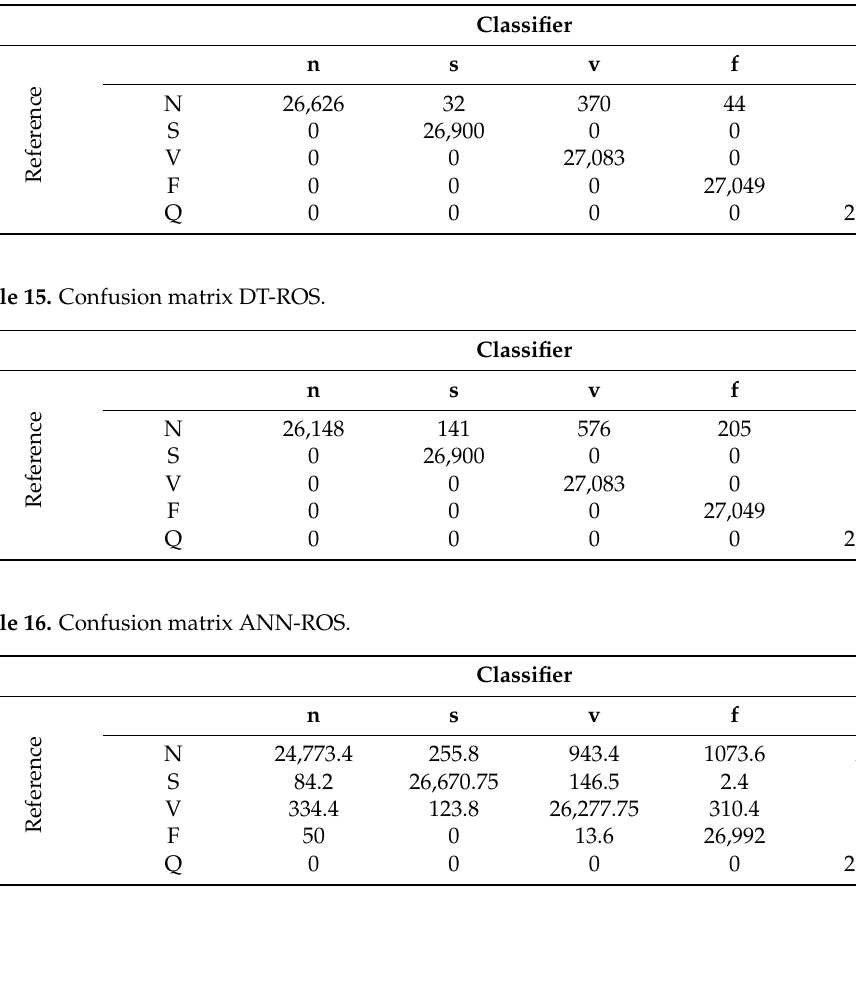
Table 14. Confusion matrix RF-ROS.